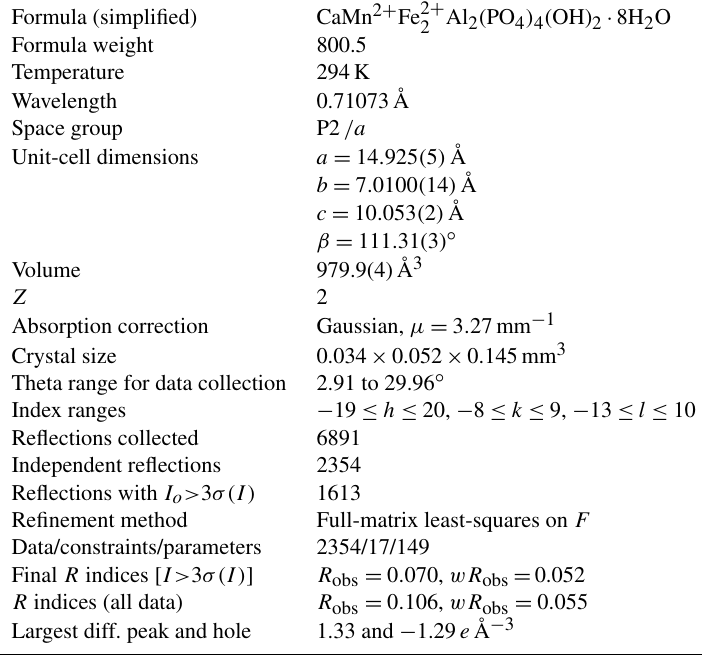
Table 3. Crystal data and structure refinement for whiteite-(CaMnFe).